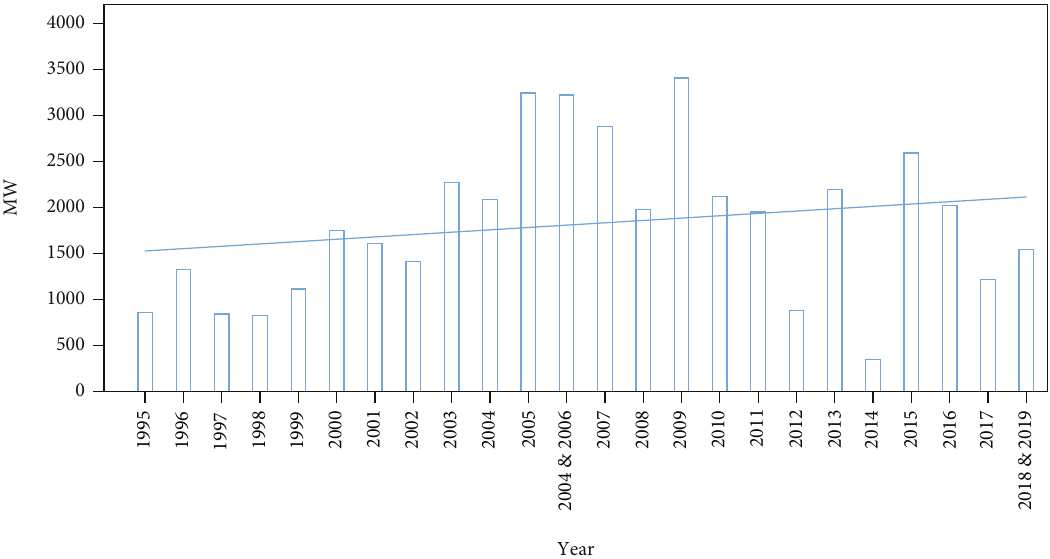
Figure 4: Construction of power plant trend (1995 to 2019). Extracted from Thermal Power Plants Holding Company database.